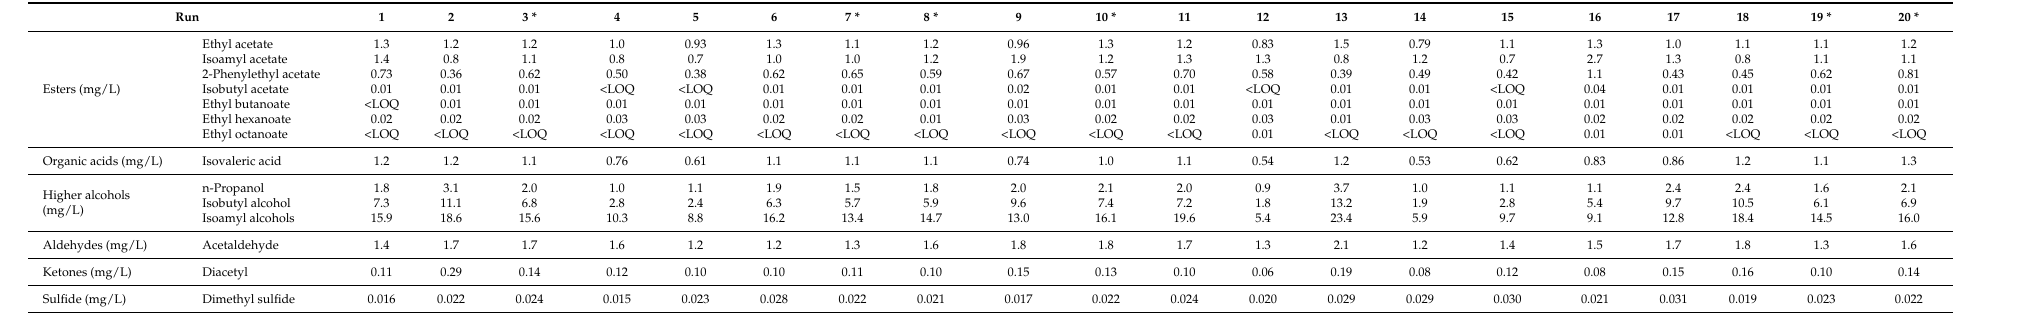
Table 5. Secondary metabolites analyzed by standard methods according to MEBAK 1 in the 20 beer samples fermented according to RSM design. Ethyl decanoate, ethyl formate, ethyl propionate, hexanoic acid, octanoic acid, decanoic acid, pentane-2,3-dione, 2-phenylethan-1-ol were measured additionally, however, are not shown as the concentrations stayed below the limit of quantitation (LOQ). An additional graphical representation can be found in the supplementary material Figure